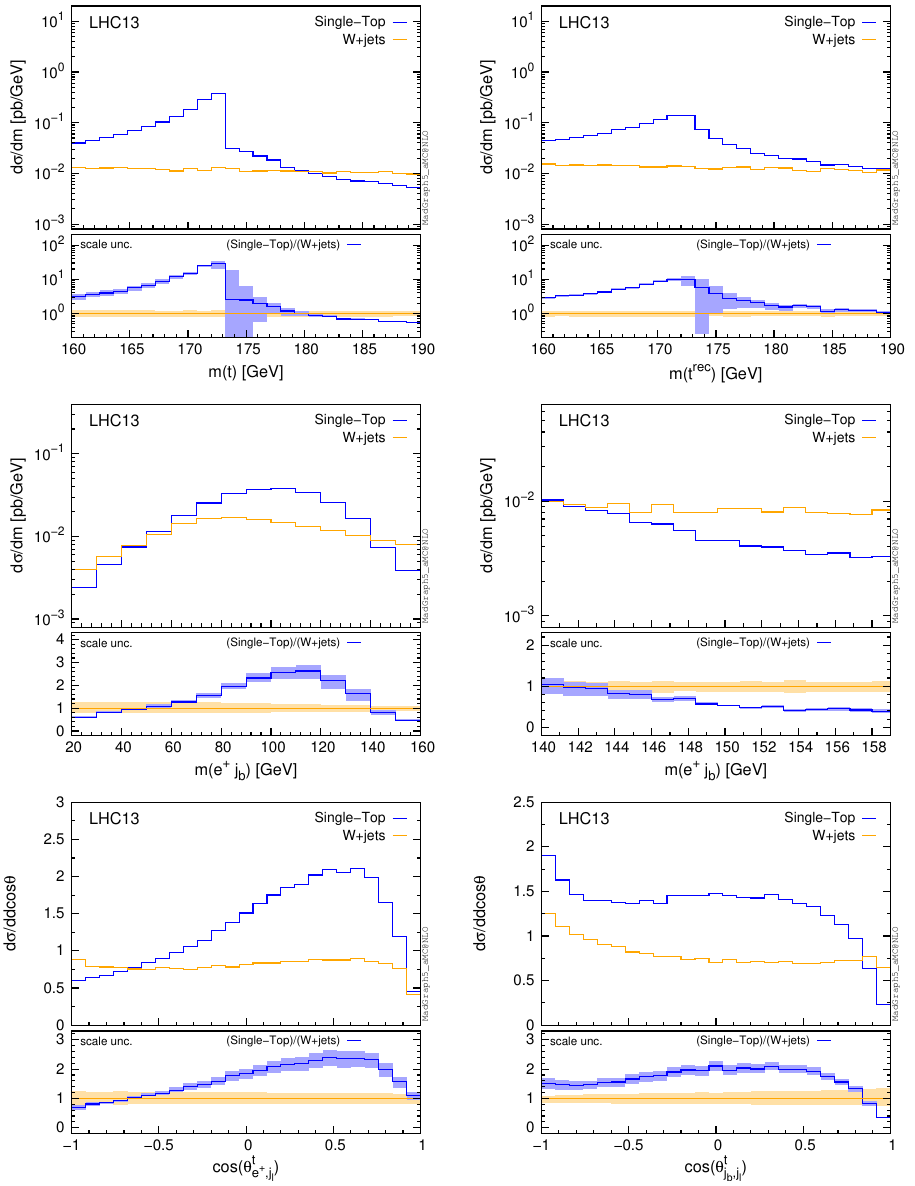
Figure 6 . Comparison between Single-Top and W +jets predictions at NLO QCD+EW accuracy for the same observables considered in (cid:12)gure